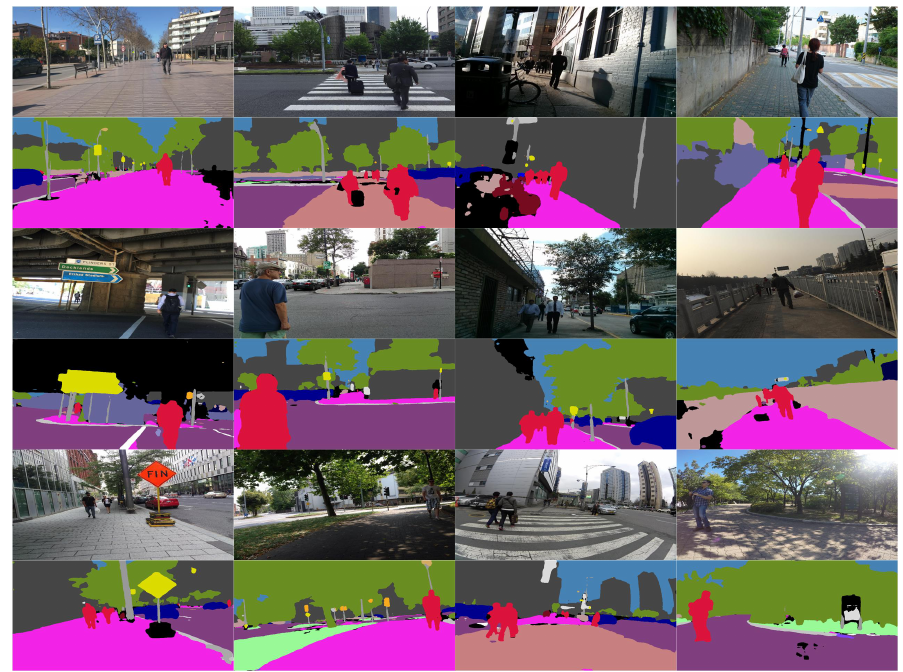
Figure 7. Qualitative examples of semantic segmentation with SwaftNet [2] on images taken from the perspective of pedestrians walking on sidewalks and